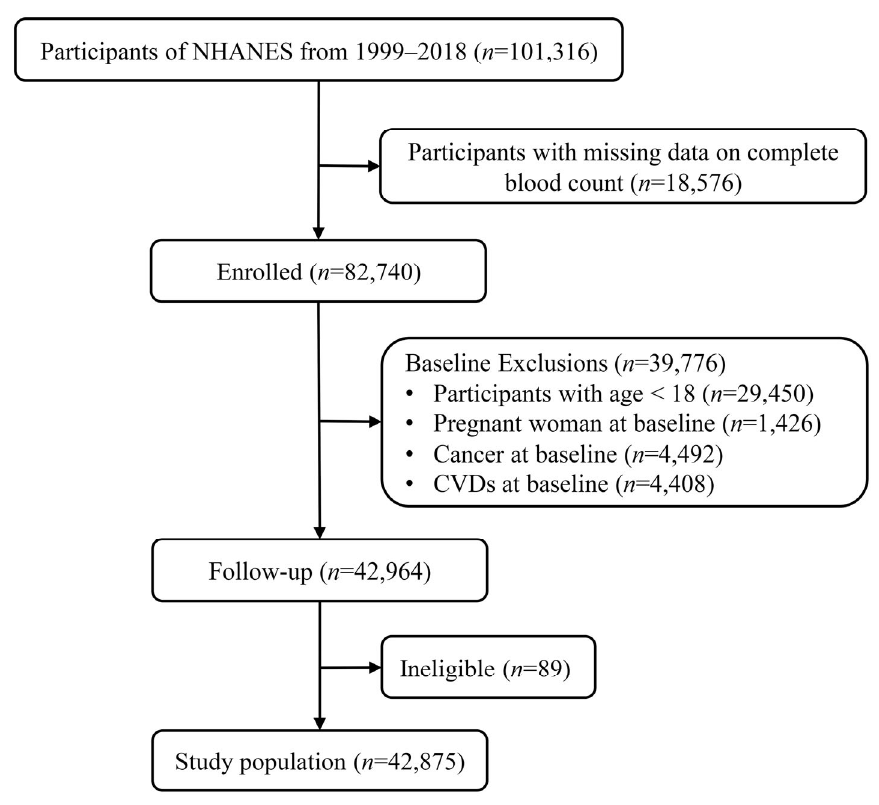
Figure 1. Flow chart of study population selection .